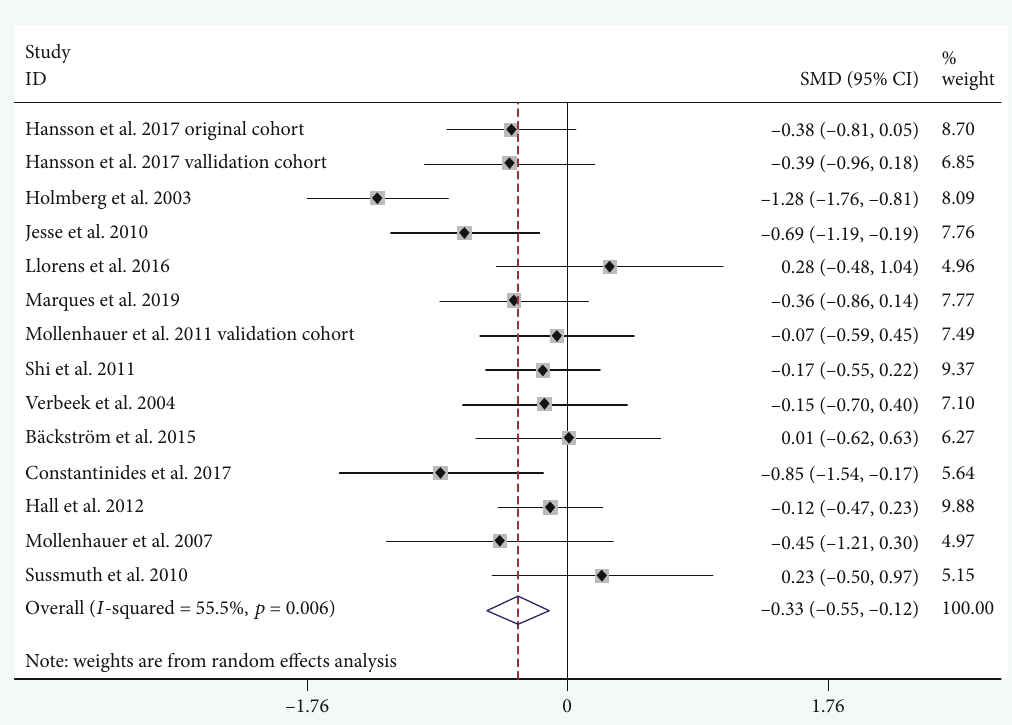
Figure 2: Cerebrospinal fl uid (CSF) levels of A β 42 in multiple system atrophy (MSA) cohorts were lower than those in Parkinson ’ s disease (PD) cohorts. SMD: standard mean di ff erence; CI: con fi dence